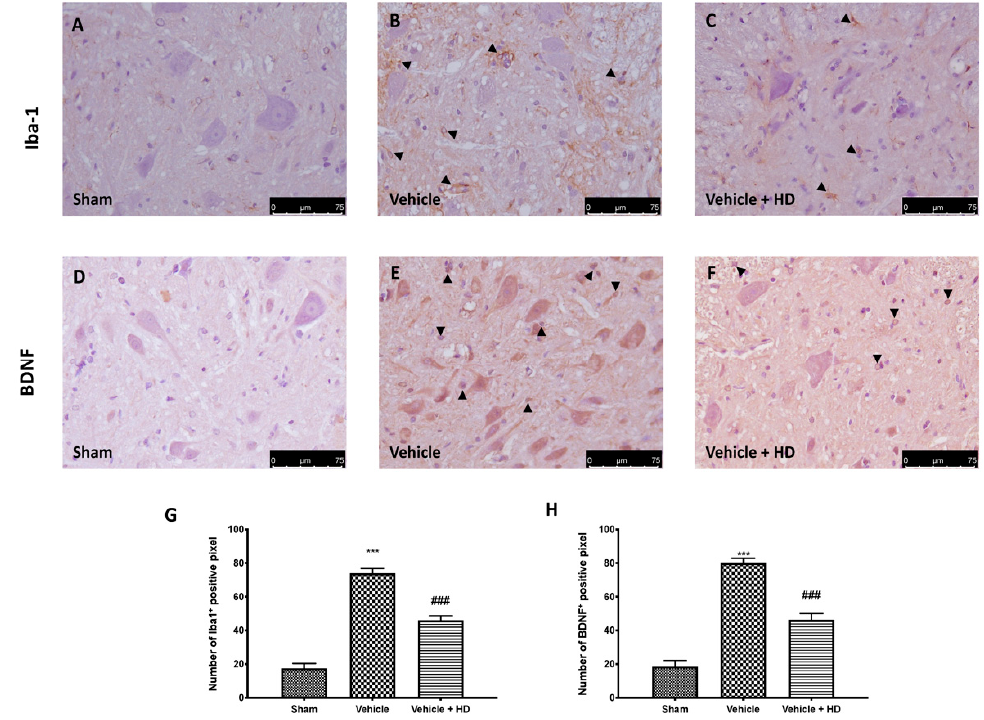
Figure 4. Effect of HD on microglia activation and BDNF expression: immunohistochemical evaluation in the spinal cord for Iba1 expression: Sham ( A ), Vehicle ( B ), Vehicle + HD ( C ) and BDNF expression: Sham ( D ), Vehicle ( E ), Vehicle + HD ( F ). Graphical quantification of Iba1 ( G ) and BDNF expression ( H ). The black arrows indicated positive cells. A 40× magnification is shown (75- μ m scale bar). *** p < 0.001 vs. sham; ### p < 0.001 vs. vehicle. 3.5. Effect of HD on Oxidative Stress It has been proven that oxidative stress is linked to the pathogenesis of FM [35]. Therefore, we investigated the Nrf2 pathway by Western blot analysis. Our results showed a small increase in Nrf-2 expression in the vehicle group compared to the sham group. A considerable increase in Nrf2 expression was induced by HD administration (Figure 5A). Consequently, Western blot analysis showed basal HO-1 (Figure 5B) and NQO-1 (Figure 5C) expression in the sham group. By contrast, the vehicle-treated group showed little increased HO-1 and NQO-1 expression, which were upregulated in HD- administered animals.